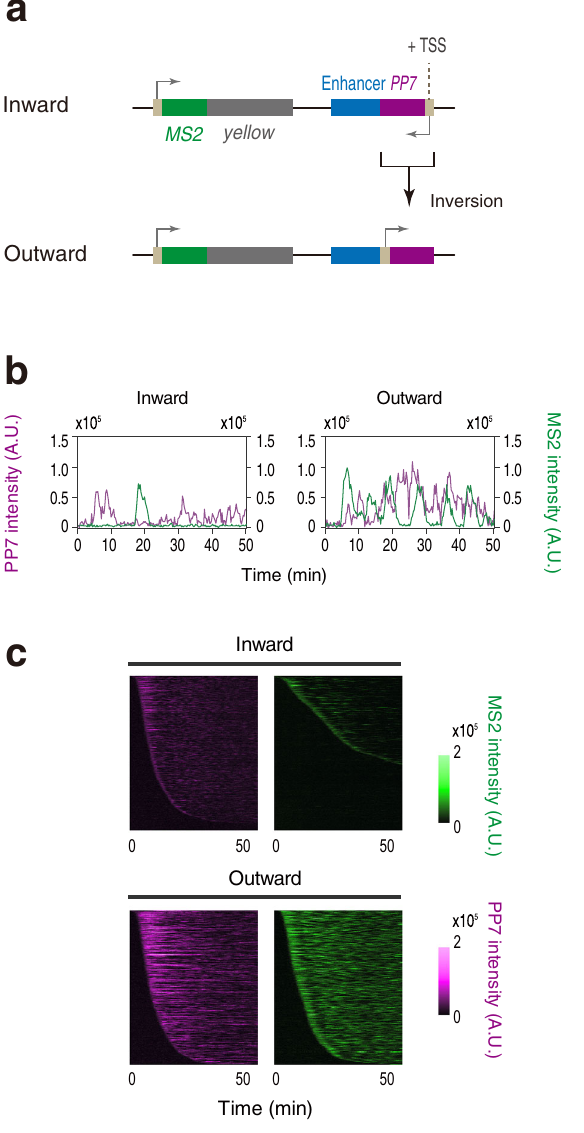
to the most extreme, non-outlier data points. e Histograms showing the distribu- tion of MS2 burst frequency. f Boxplot showing the distribution of MS2 burst size. The box indicates the lower (25%) and upper (75%) quantile and the white line indicates the median. Whiskers extend to the most extreme, non-outlier data points. A total of 845 and 4220 MS2 bursts, respectively, were analyzed for the reporterlocusdrivingPP7transcriptioninaninwardoranoutwardorientation.The double hash mark on the y-axis indicates that >99% of the data points are pre- sented. g BoxplotshowingthedistributionofthetotaloutputofMS2transcription. The box indicates the lower (25%) and upper (75%) quantile and the white line indicates the median. Whiskers extend to the most extreme, non-outlier data points. A.U.; arbitrary unit. Percentages shown at the bottom of the boxplots representtherelativevaluesofthemedian. P valueswerecalculatedbyatwo-sided Wilcoxon rank-sum test. Source data are provided as a Source Data fi